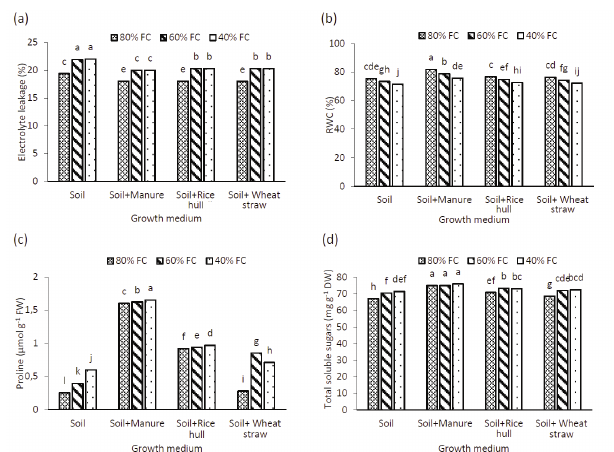
Fig. 3 ­ Electrolyte leakage (a), RWC (b), proline (c), and total soluble sugar (d) in hollyhock plants under different medium. Values in columns followed by the same letter are not significantly different at the 0.05 level